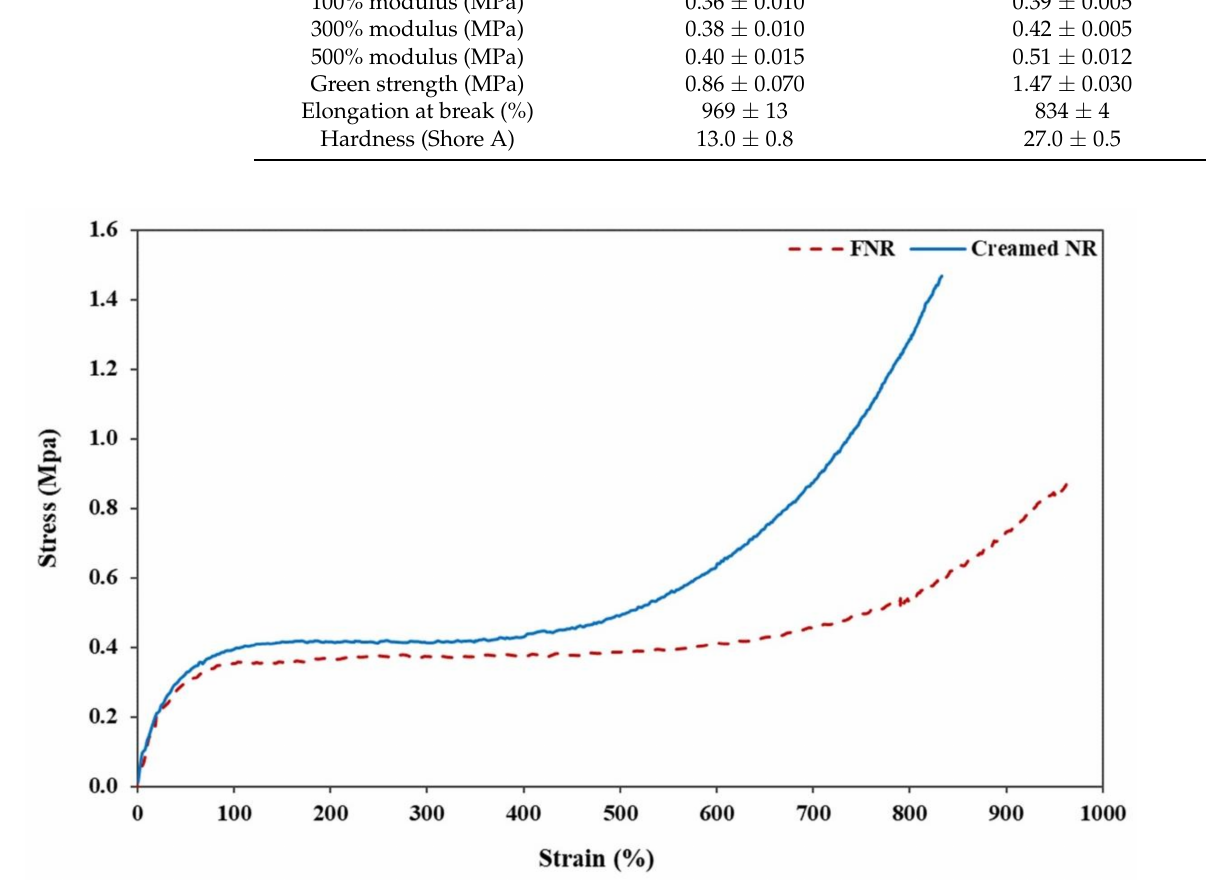
Figure 10. Stress-strain curve of fresh natural latex and cream concentrated latex from RRIM600